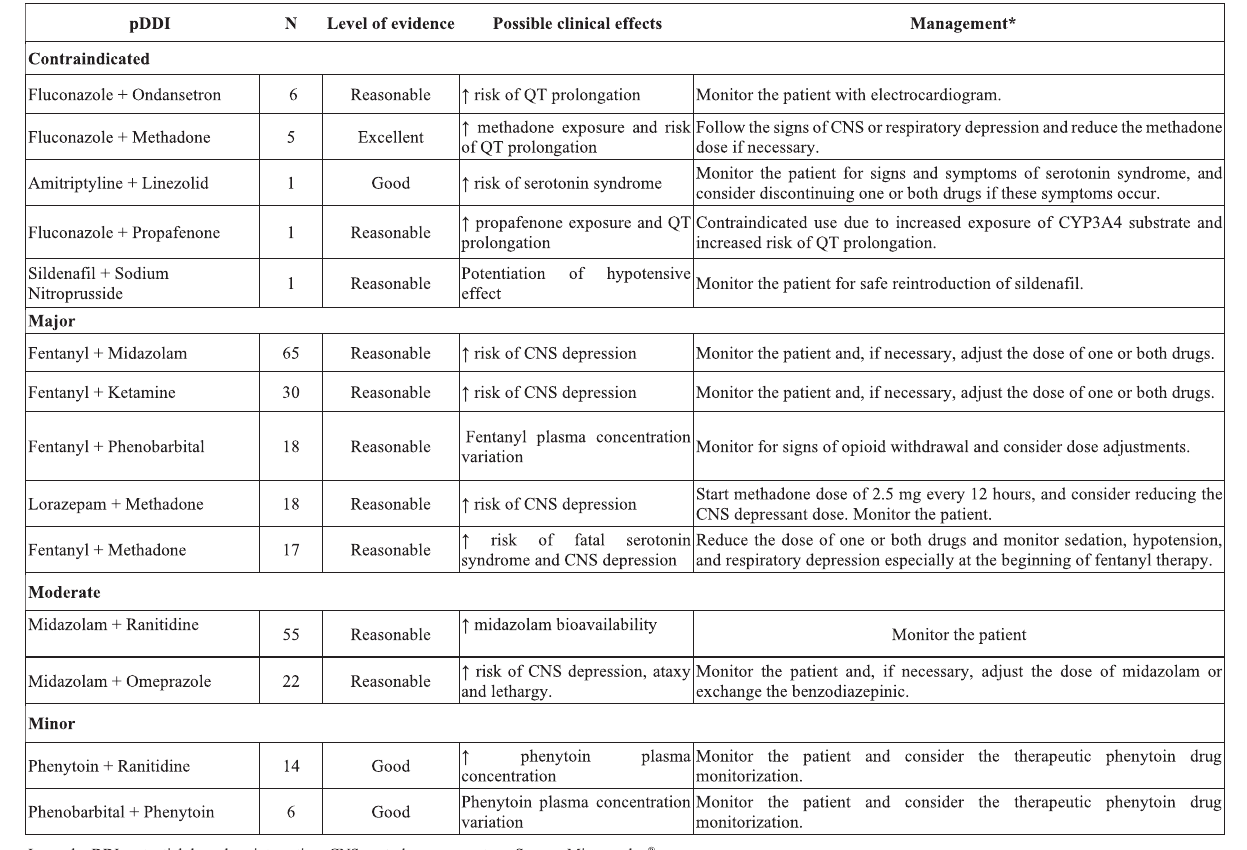
FIGURE 2 | Description of the fi ve most frequently contraindicated and major pDDIs (Teaching Hospital PICU, Rio de Janeiro, Brazil – May/2014 – April/2015, n (cid:1) 1,123). *Source as: Micromedex Healthcare Series 2019.